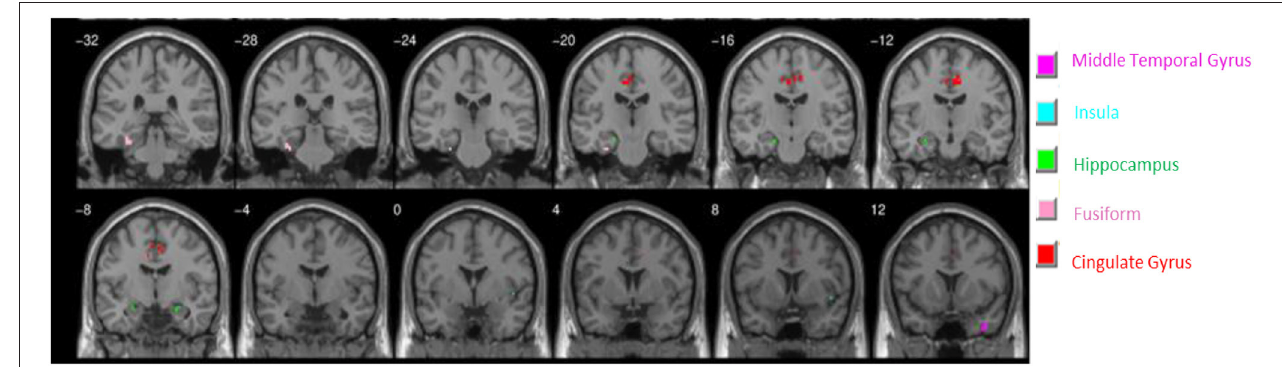
FIGURE 2 | Non-Fans > Fans Contrast . Cluster activation for the contrast of the Non-Fan > Fan groups across all conditions. Non-fans reliably show more activation in key areas of the brain compared to fans.